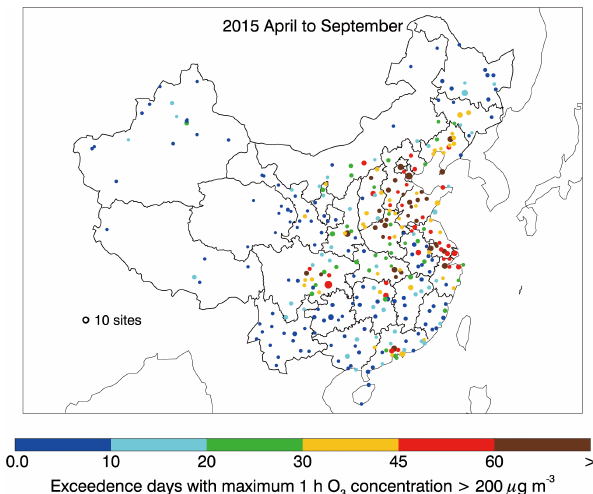
Figure 3. Distribution of average daily maximum 1h [O 3 ] in main- land China from April to September 2015.